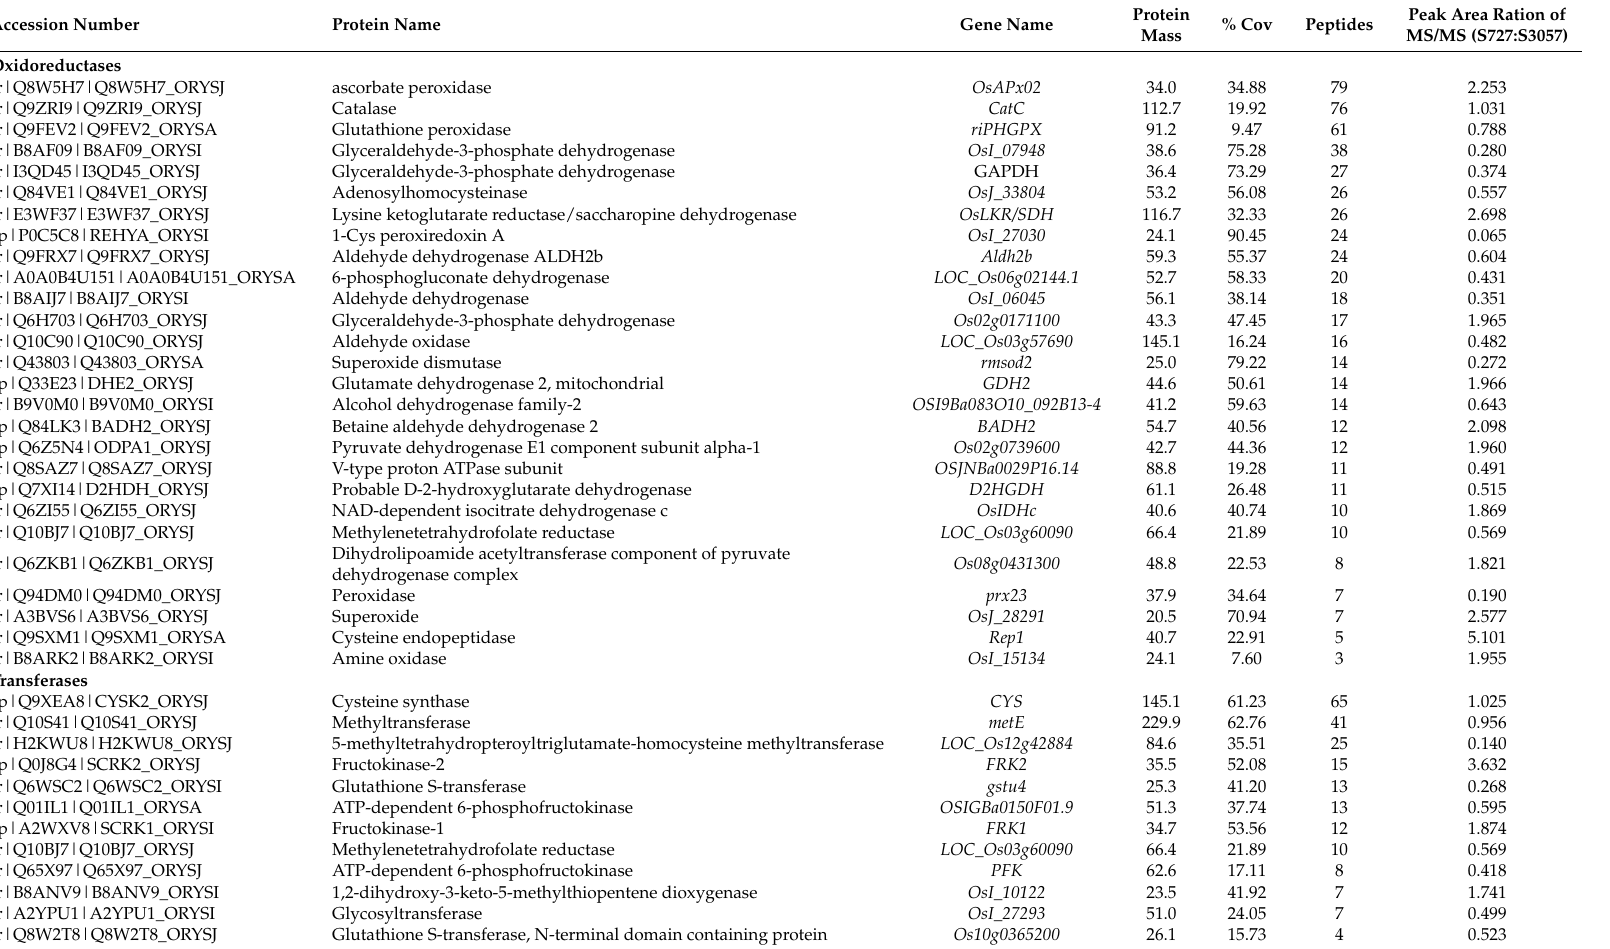
Table 5. Significantly differentially expressed proteins in S727 and